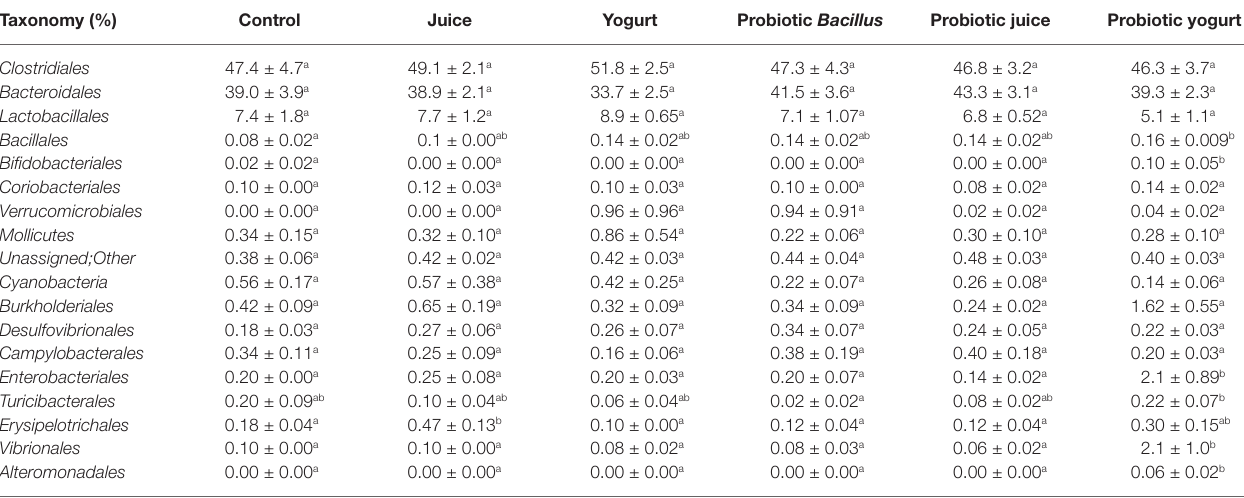
* Groups were as follows: Control: received distilled water; Juice: received orange juice; Yogurt: received yogurt; probiotic Bacillus: received B. coagulans GBI-30 6086 suspended in distilled water; Probiotic Juice: received orange juice with B. coagulans GBI-30 6086; and Probiotic Yogurt: received yogurt with B. coagulans GBI-30 6086; Data are expressed as means ± SEM. Different superscript letters on the same line indicate statistical differences by the Duncan test (p <